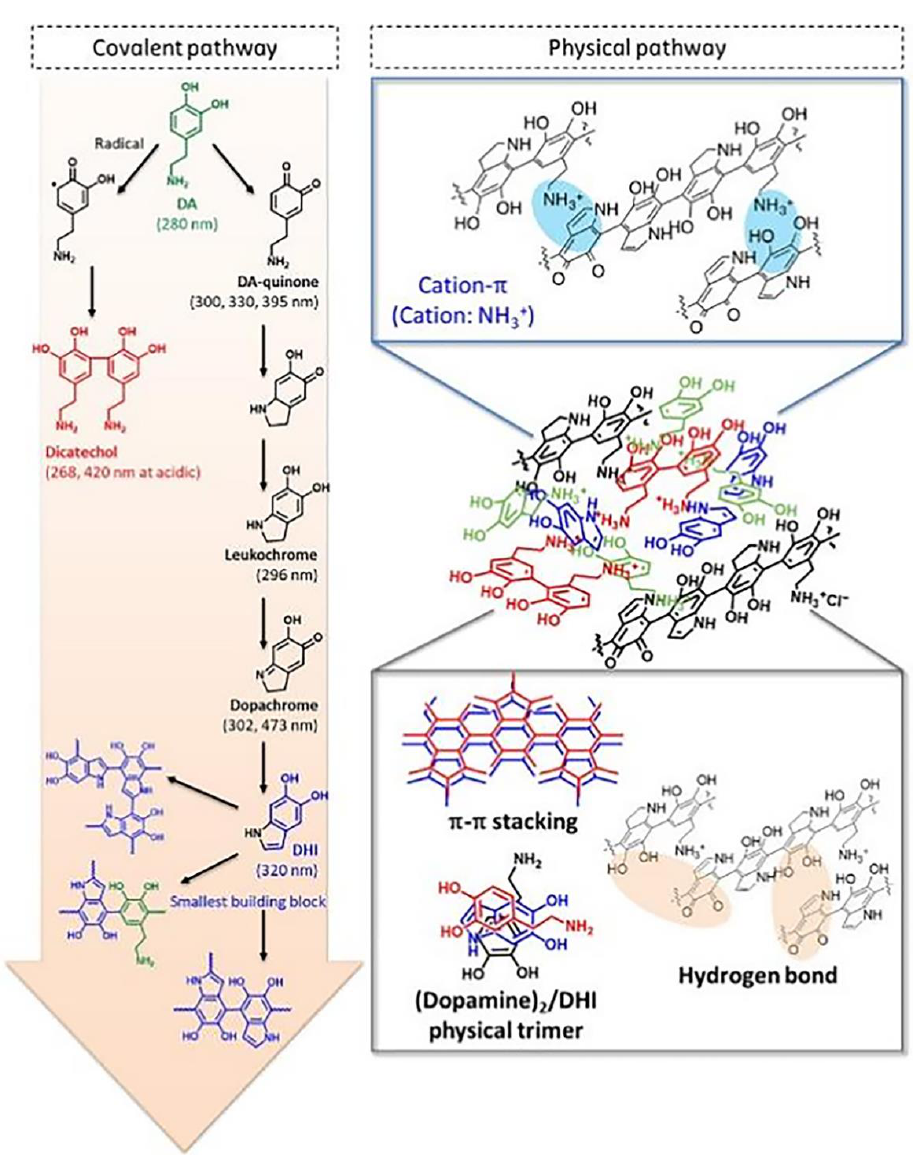
Figure 2. PDA synthesis pathways: covalent pathway and physical self-assembly pathway with main interaction. Reproduced with permission from ref. [13]. Copyright © 2018, American Association for the Advancement of Science.